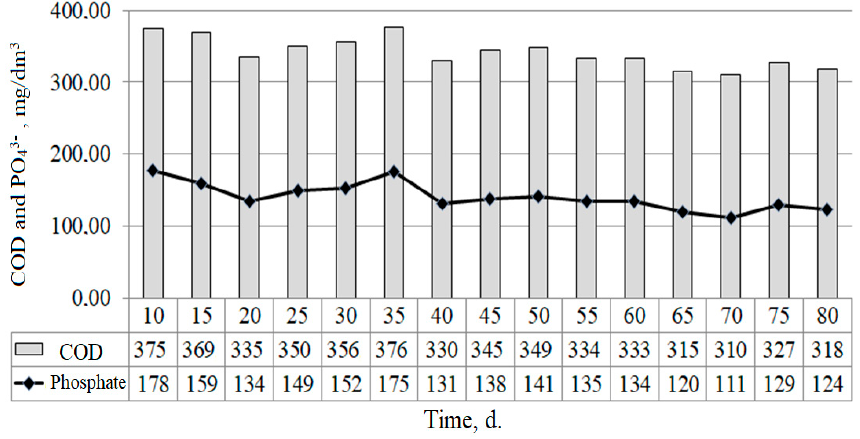
Figure 12. Dynamics of COD before anaerobic conversion and phosphate concentration after treatment.